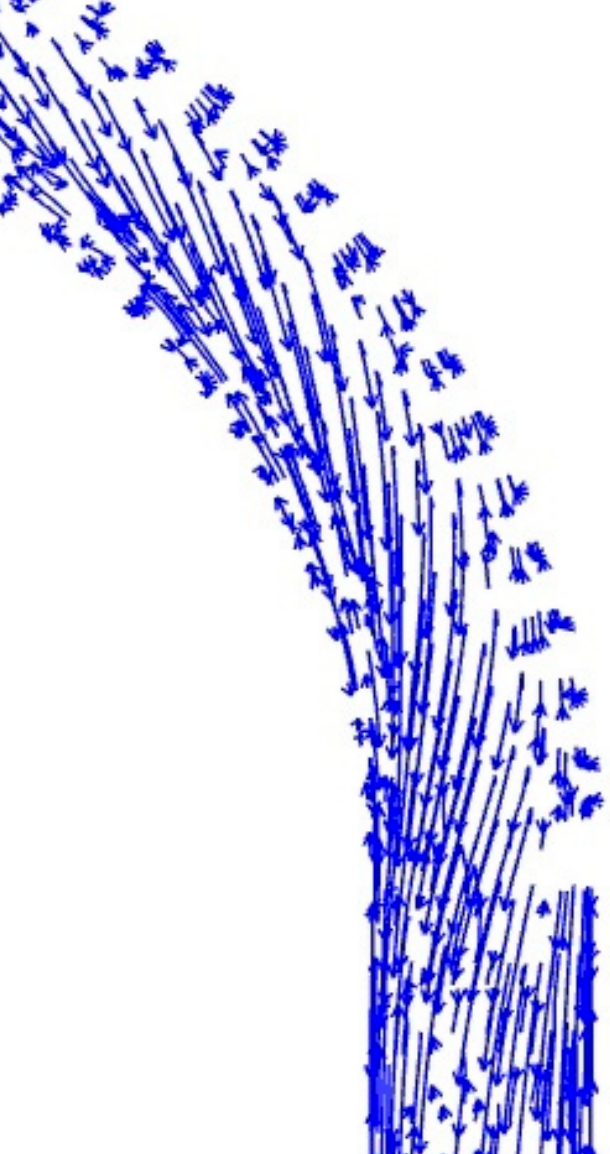
Figure7. The path lines of the velocity at the bend pipe. Figure 7. The path lines of the velocity at the bend pipe. The cross-section diagram of vertical pipe velocity (Y = 1.6 m) illustrates that the high-velocity area located in the center of the pipe will expand with the increase of velocity. The high-velocity zone in the center will expand more and more as the CPB slurry moves down following the vertical pipe. The velocity cross-sections of the elbow and horizontal pipe also reveal the influence of inlet velocity on the velocity distribution of slurry in the pipe. When the inlet flow rate reaches 3.2 m/s, the CPB slurry returns to the standard “plunger flow” condition more quickly in the horizontal